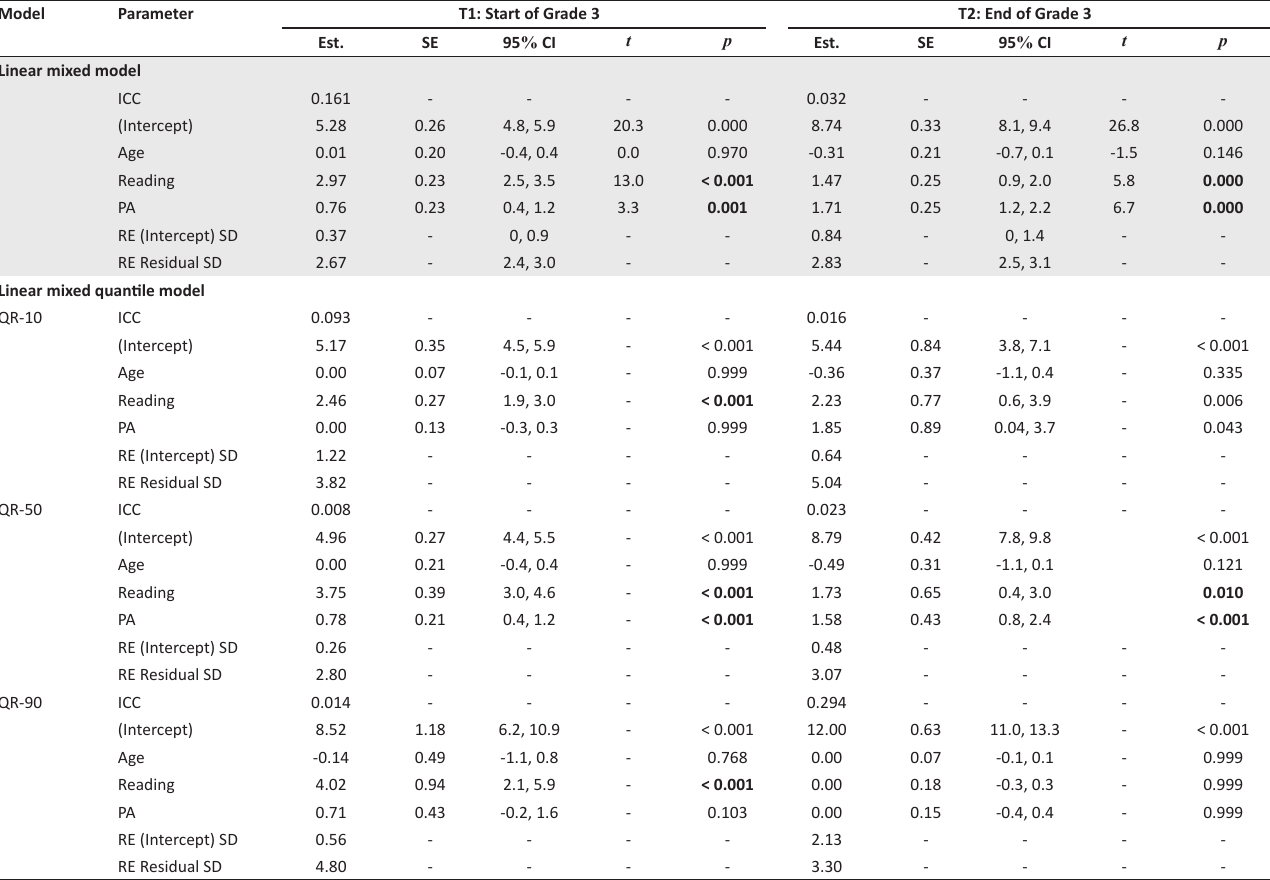
TABLE 4: Study 2: Results from mixed-effects models at the mean, and 0.1, 0.5 and 0.9 quantiles at the start of grade 3 (school random effects) and end of grade 3 (teacher random effects).